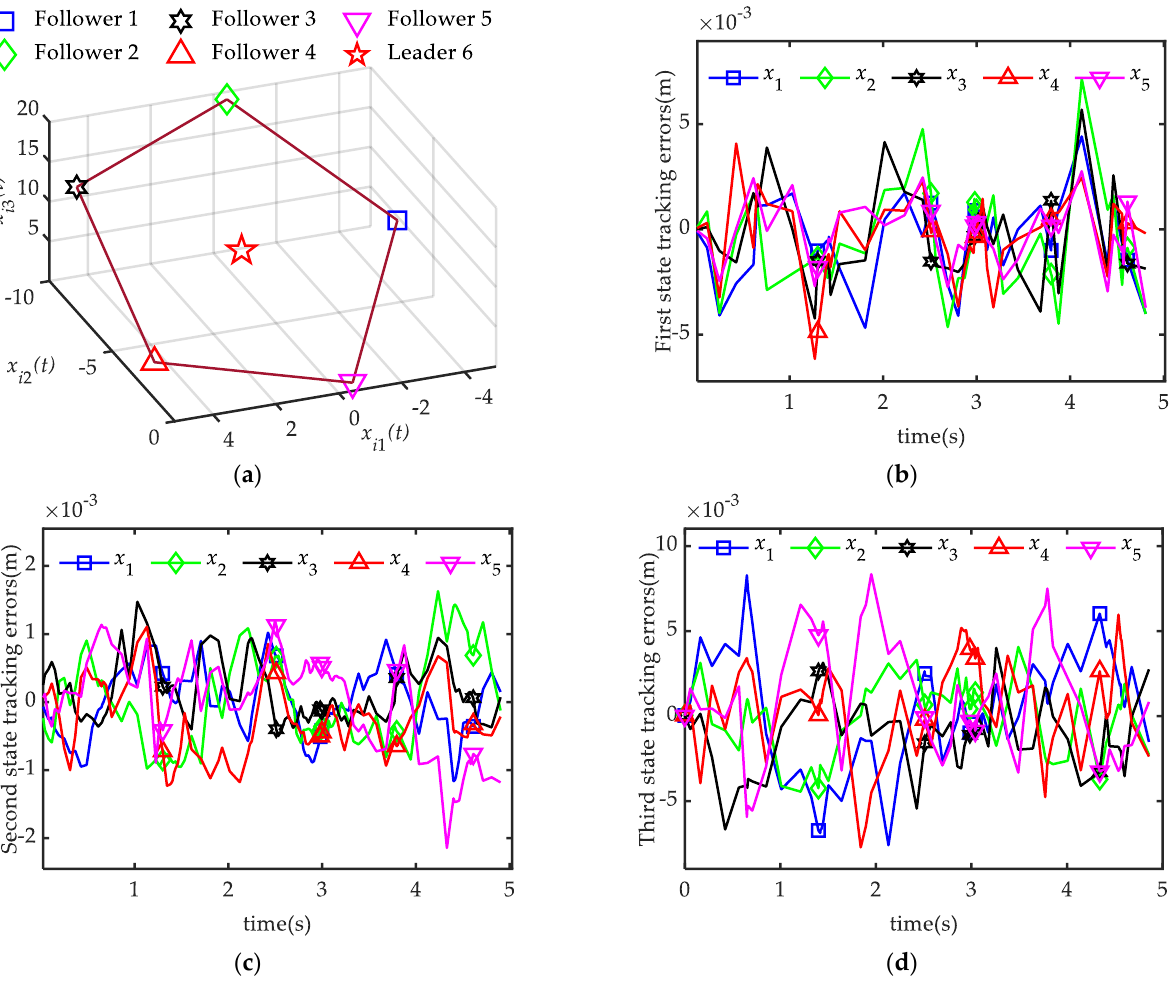
Figure 6. States snapshot of all the agents when t = 5 s and state tracking errors x i − h i − x N + 1 , i = 1,2, · · · ,5 of five followers with Gauss white noise disturbance. ( a ) States snapshot of all the agents when t = 5 s; ( b ) First state tracking errors x i 1 − h i 1 − x N + 1,1 , i = 1,2, · · · ,5; ( c ) Second state tracking errors x i 2 − h i 2 − x N + 1,2 , i = 1,2, · · · ,5; ( d ) Third state tracking errors x i 3 − h i 3 − x N + 1,3 , i = 1,2, · · · ,5.